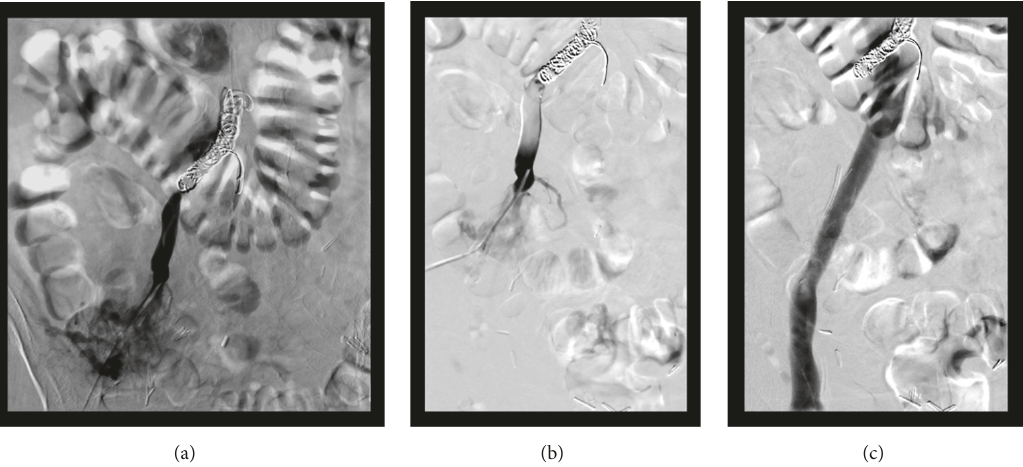
Figure 3: Fluoroscopic images of the right lower quadrant. (a) Venography after embolization with coils demonstrates hemostasis. (b) Subsequent venography after embolization with glue demonstrated sluggish flow in the portosystemic shunt with multiple filling defects withinthevisualizedcollateralsconsistentwithembolization.(c)Injectionoftherightfemoralveindemonstratedflowfromtherightcommon femoral vein through the iliac system and IVC without opacification of the peristomal